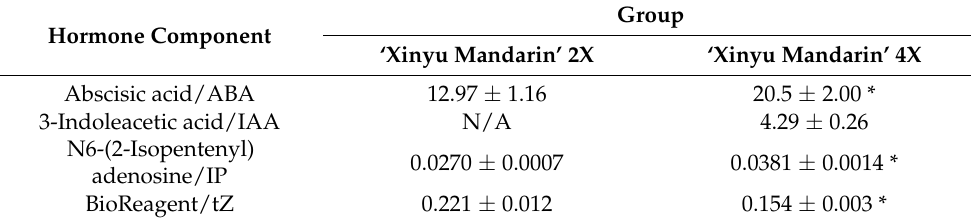
Table 1. The content of 10 common hormones in two samples (ng/g,